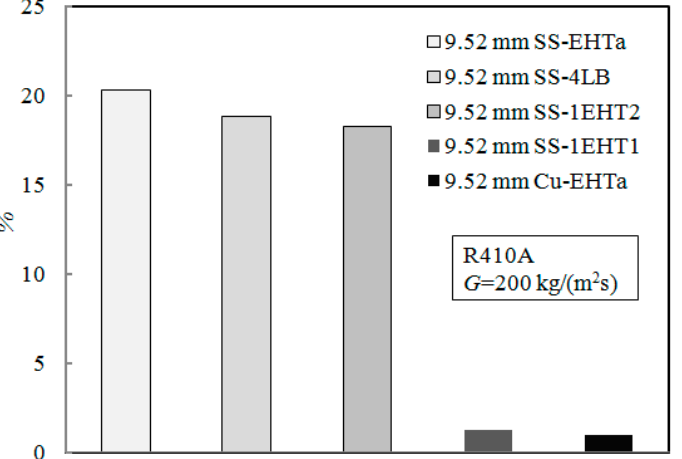
Figure 10. Comparison of thermal resistance (for various tube types) to total evaporation thermal resistance for 9.52 mm OD tubes. Data of the 9.52 mm OD SS-4LB tube, 9.52 mm OD SS-1EHT1 tube and 9.52 mm OD SS-1EHT2 tube are from K Shen et al. [15]; data of the 9.52 mm OD Cu-EHTa tube and 9.52 mm OD Cu-EHTb tube are data are from Sun et al. [13].